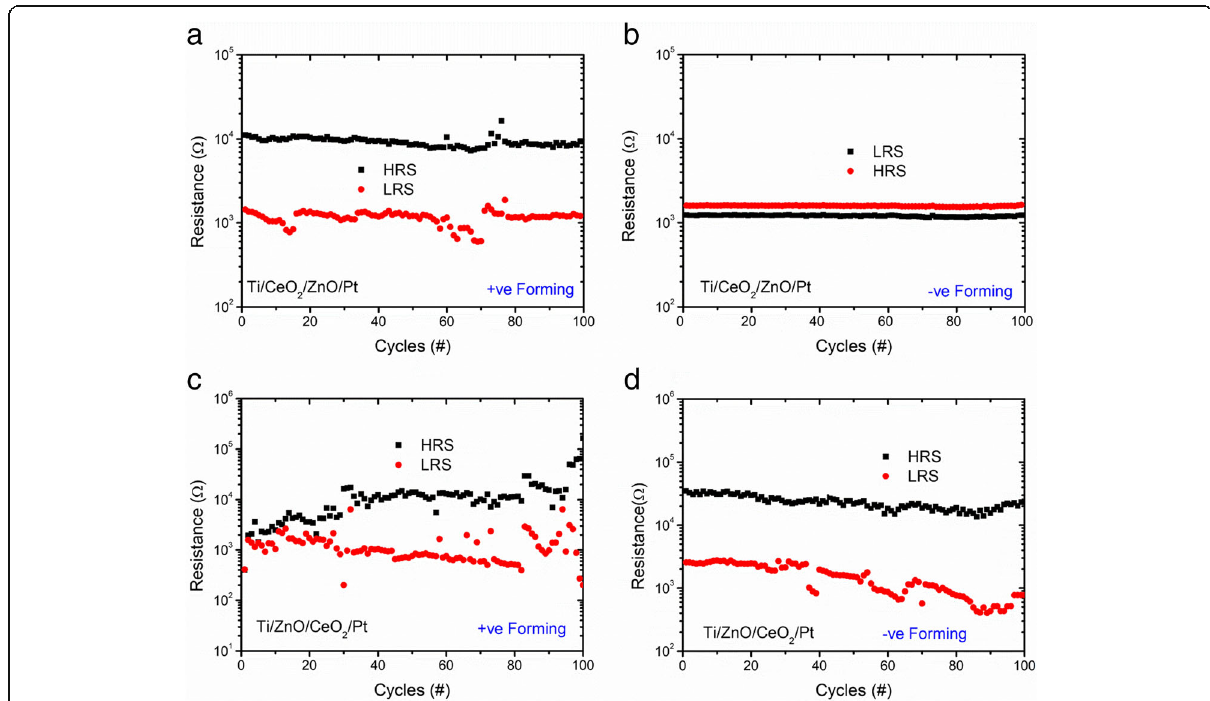
Fig. 4 Endurance characteristics of a positively electroformed and b negatively electroformed Ti/CeO 2 − x /ZnO/Pt heterostructure memory devices. c Positively electroformed and d negatively electroformed Ti/ZnO/CeO 2 − x /Pt heterostructure memory